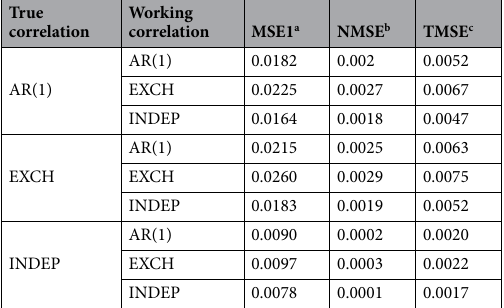
Table 2. Estimation accuracy of the pQIF method under three types of working correlations, AR(1), EXCH (exchangeable), INDEP (independent). a MSE1 = mean squared error of the four nonzero coefficients for age, MAP4 , TNN , and NRF1 . b NMSE = mean squared error for all the noisy gene variants in the model. c TMSE = total mean squared error for all the variables in the